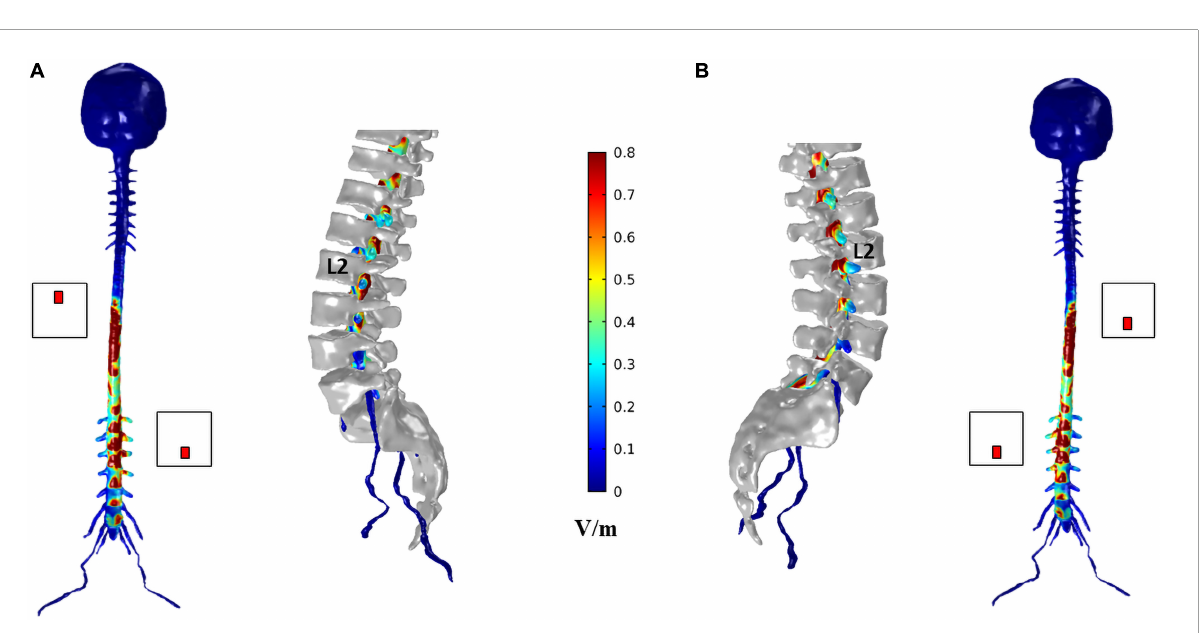
were obtained for improving accuracy (American Clinical Neurophysiology Society, 2006). The recording electrodes were placed on: ipsilateral popliteal fossa (referred to the patella);